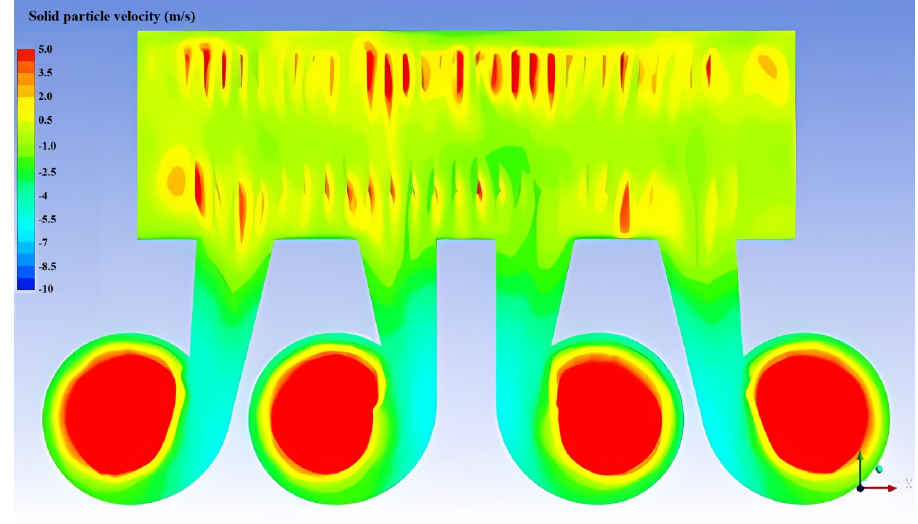
Figure 4. Axial velocity distribution of solid phase at 50 m distance from air distribution plate.